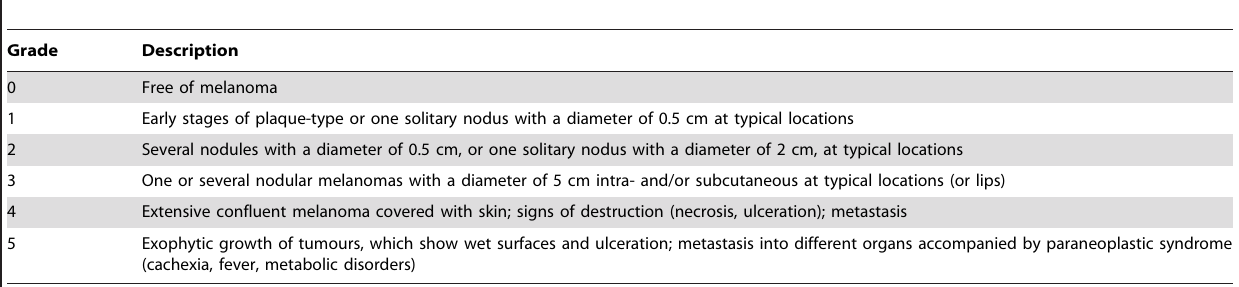
Table 4. Clinical classification of melanoma grade in grey Lipizzan